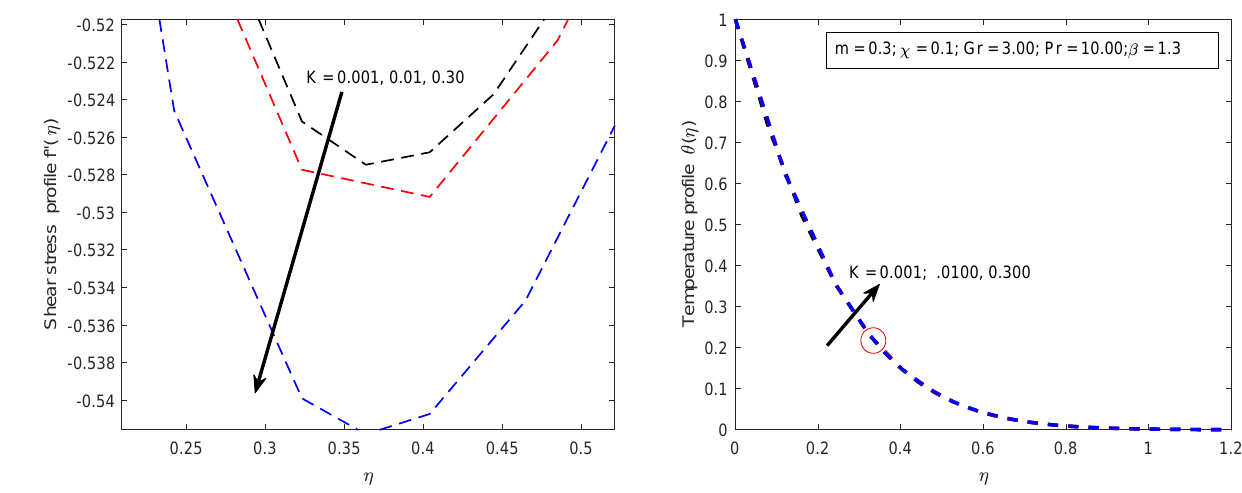
Figure 6: A zoomed portion of the boundary layer of Fig.(5)